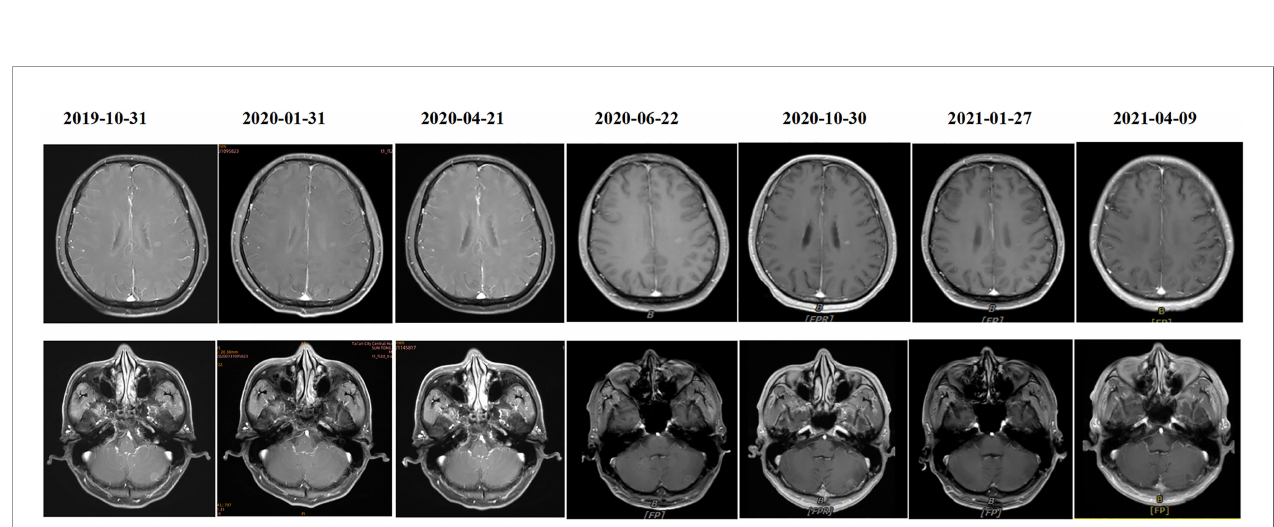
FIGURE 3 | Gene detection diagram and levels of carcinoembryonic antigen (CEA) during treatment. (A) Gene detection diagram during the treatment was shown. Different colors represent different genes and different wave widths. The number on the vertical axis represents the mutation frequency (wave width). (B) The levels of CEA, including serum CEA and cerebrospinal fl uid CEA, were